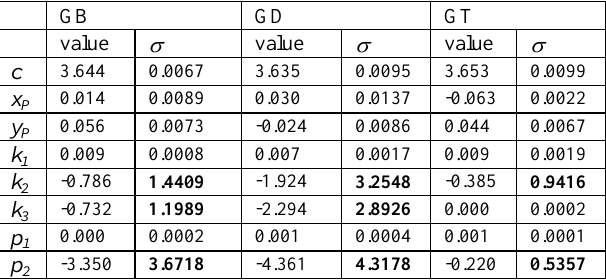
Table 4: Interior Orientation parameters of all three cameras using the 12MB dunk test series (in mm).